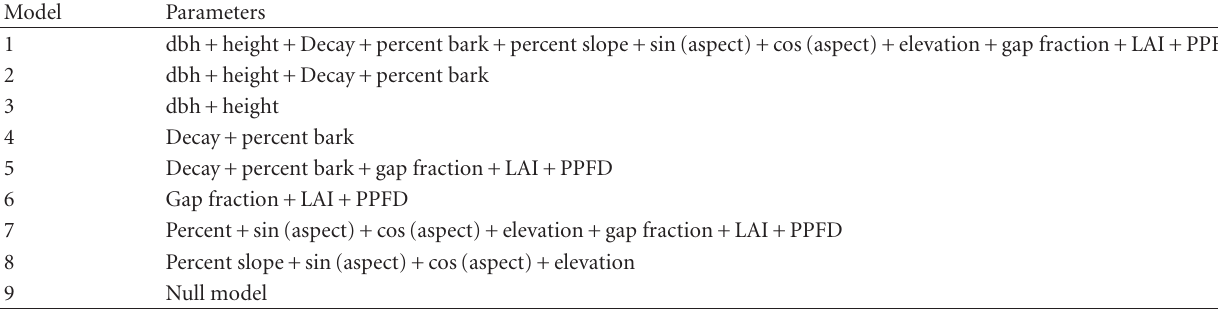
Table 1: Candidate model sets used to compare female Myotis septentrionalis day-roost species selection and day-roost selection by maternity status on the Fort Knox military reservation in Hardin, Bullitt, and Meade counties, Kentucky, USA,